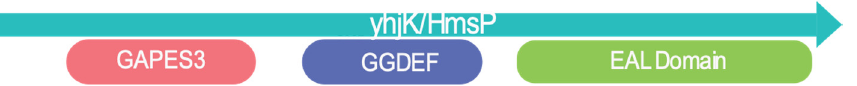
Figure 2. Domain analysis of the predicted YhjK/HmsP protein to demonstrate its relevance in cellulose operon.